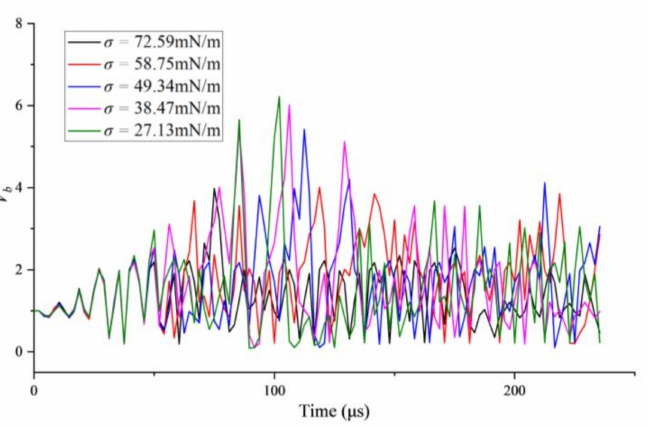
Figure 4. The volume of the single bubble versus time in liquids with different surface tensions.